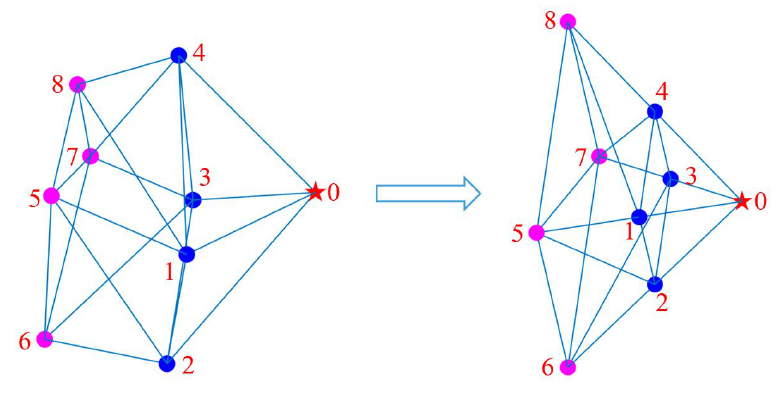
Figure 4. Formation